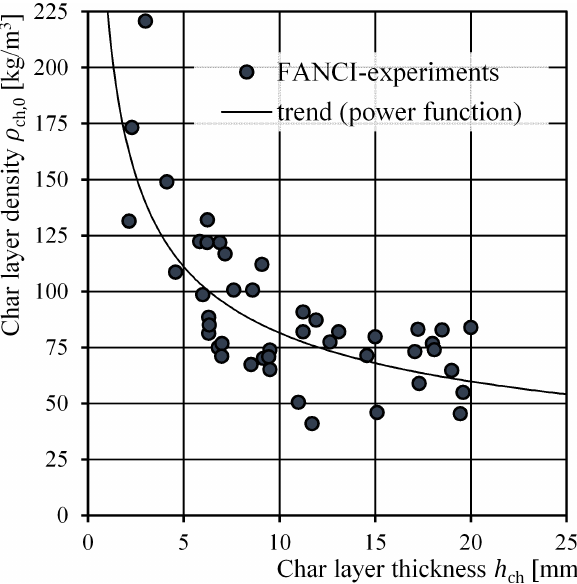
Figure 9: Developed relation for the char layer density (dry) as function of the char layer thickness.